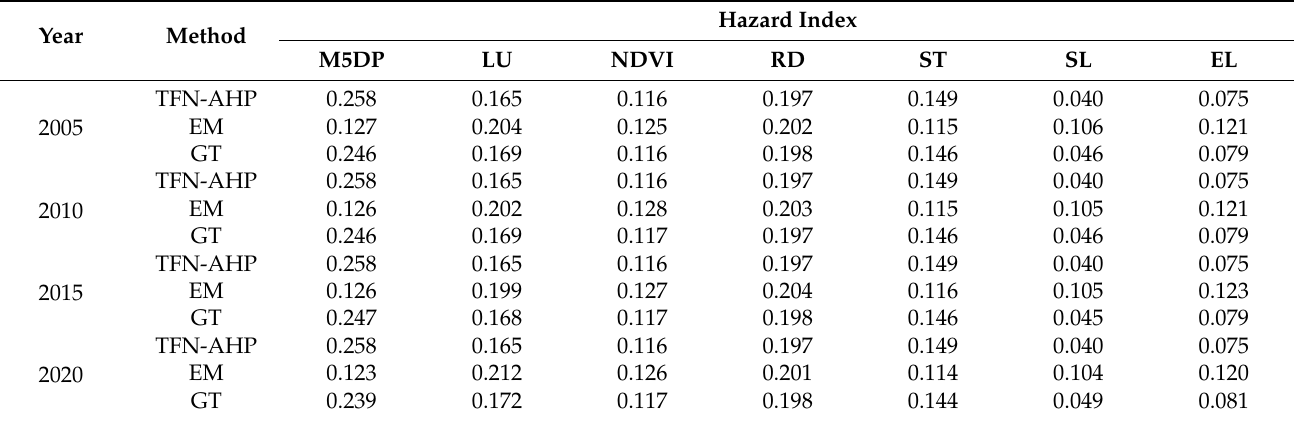
Table 4. Hazard index weights obtained via the three